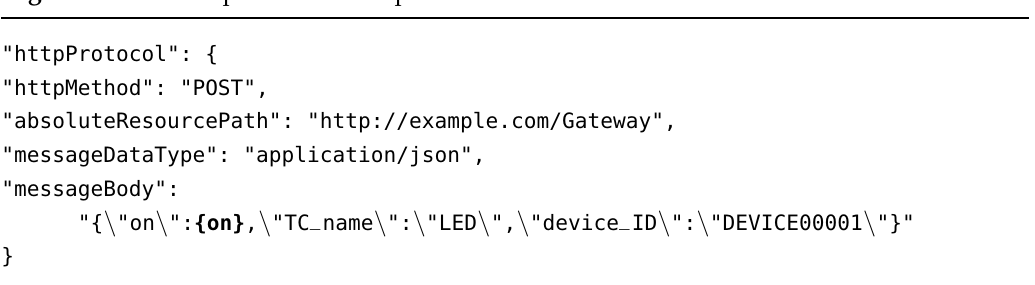
Algorithm 1. An httpProtocol example.